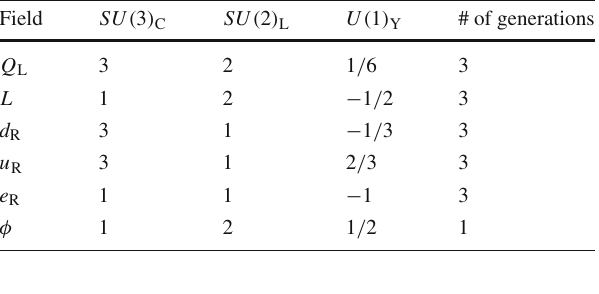
Table 2 Quantum numbers for the SM fields. Here, Q L , d R , u R are the quark fields, L and e R are the lepton fields, and φ is the Higgs doublet